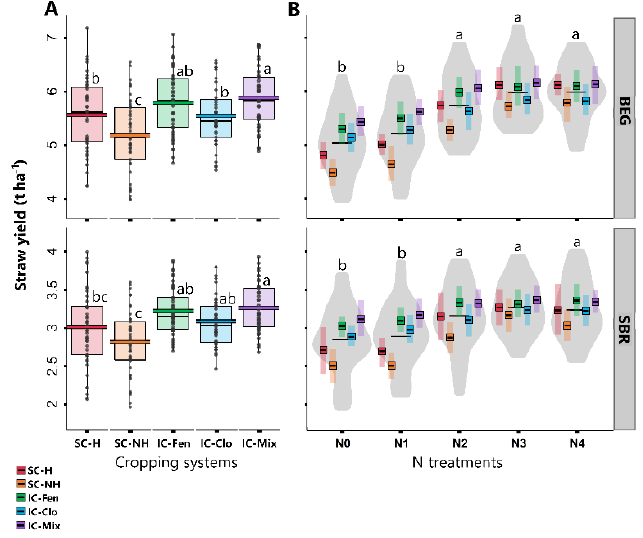
Figure 5. Effects of cropping pattern and N treatment on the straw yield at both sites averaged across the three experimental seasons.( A ): Box plot indicating the cropping pattern effects on the straw yield averaged over the three seasons and the five N treatments;( B ): Violin plot indicating the N treatment effects on the straw yield averaged over the three seasons and the five cropping patterns (black lines indicate mean grain yield; Tiles represent the means and 95% confidence intervals according to the cropping pattern in each N treatment); Box plots ( A ) and violin plots ( B ) with a common letter are not significantly different at p < 0.05 according to Tukey’s HSD-test (for statistical output see Table S3).